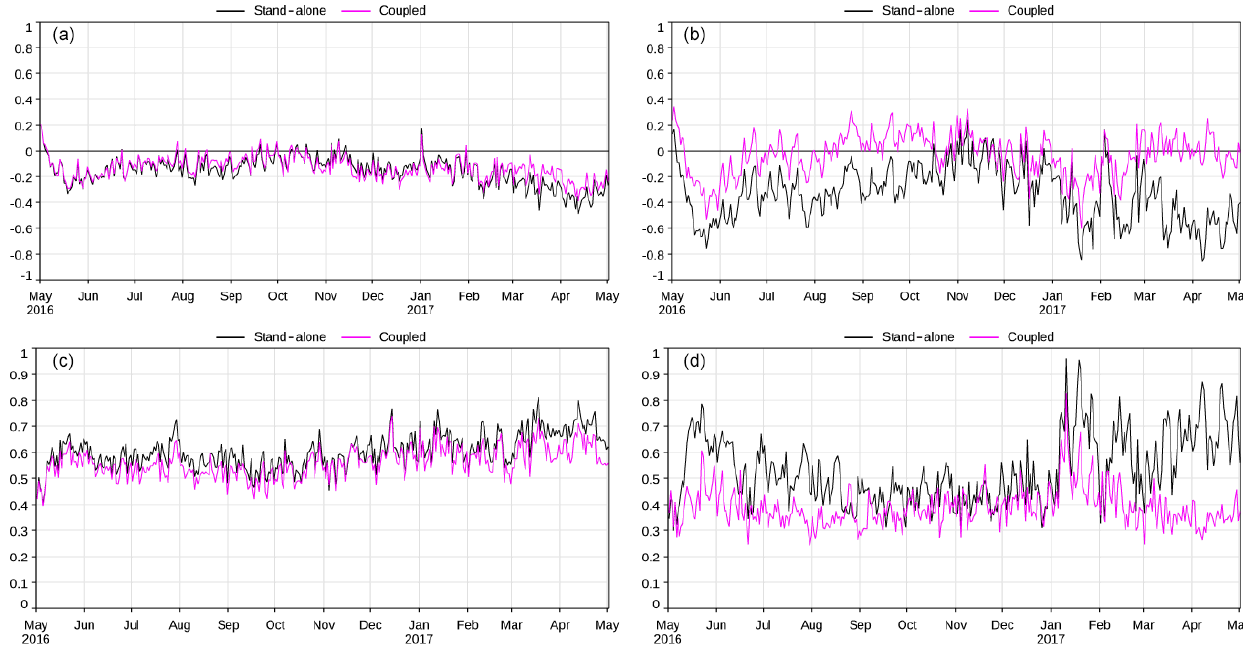
Figure 11. Global (a, c) and European (b, d) modified normalized mean bias (MNMB; a, b ) and fractional gross error (FGE; c, d ) of daily AOD at 500nm simulated by stand-alone (black) and coupled (violet) IFS-AER cycle 45R1 against observations from AERONET.